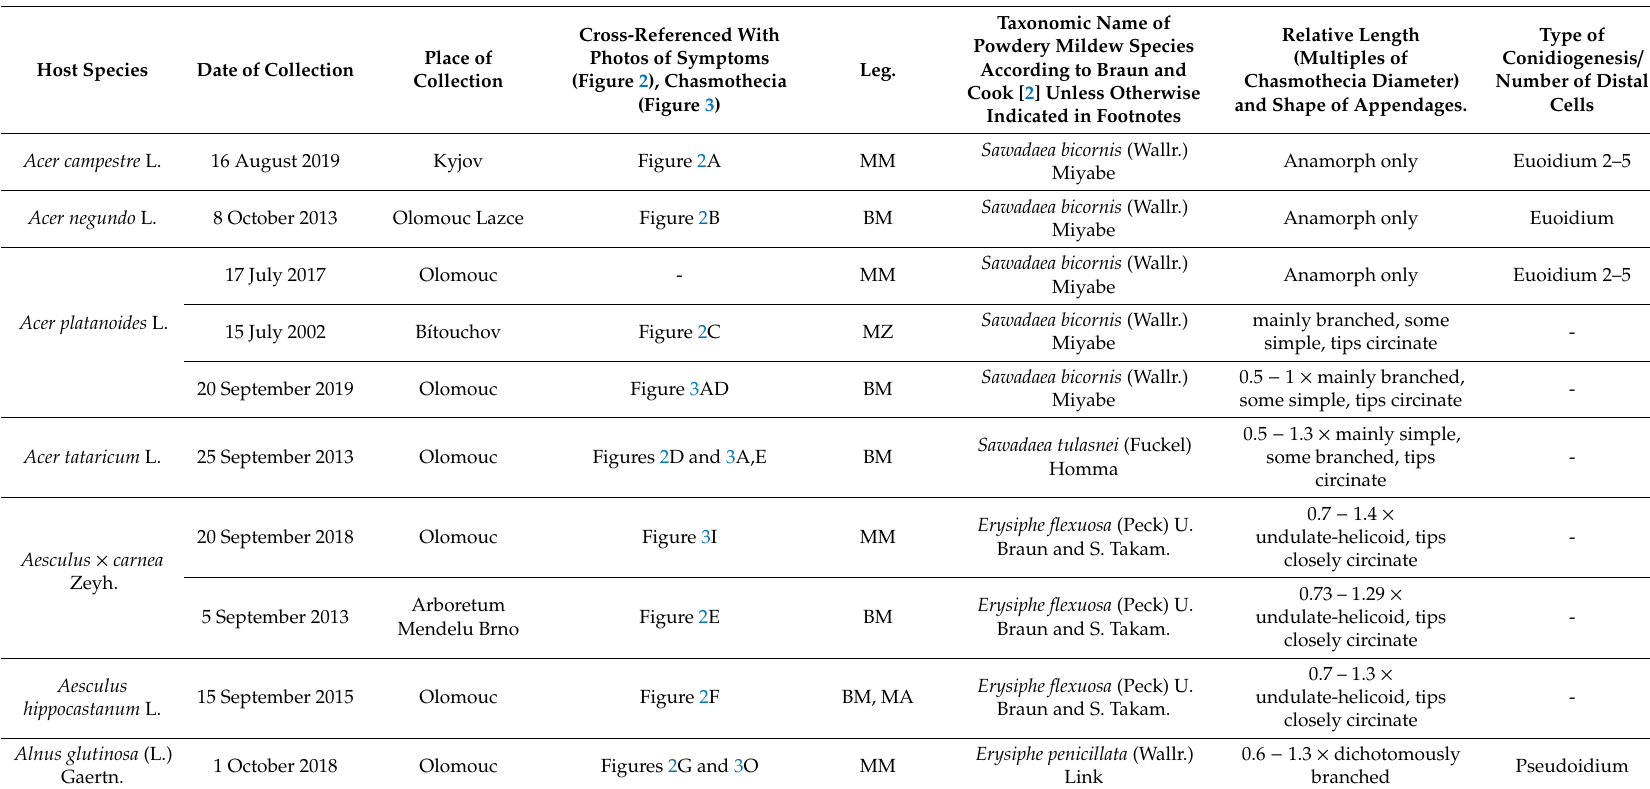
Table 1. List of representatives of trees and shrubs infected by powdery mildews collected during 2002–2019 in the Czech